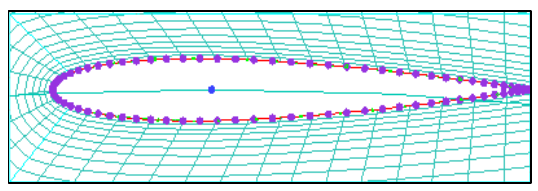
Figure 6. CFD domain in ANSYS Fluent